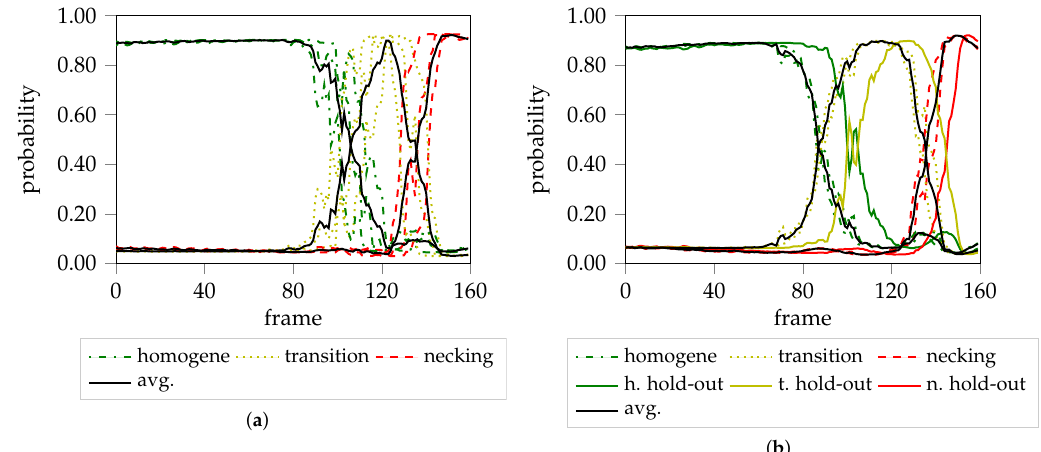
Figure 7. Differences between the lomocv and losocv experiment for DX54D-S060 (0.75 mm). ( a ) Probability progression for all three hold-sequences (losocv). ( b ) Probability progression for one hold-out sequence vs. The training sequences